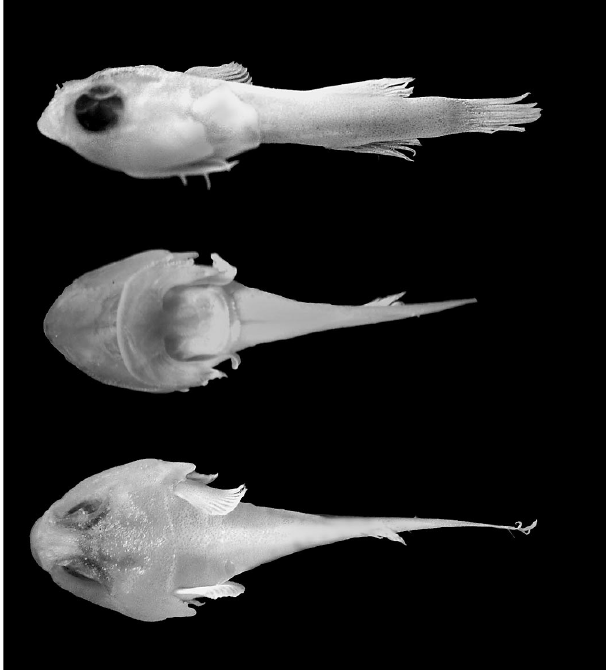
Fig. 1. Acyrtus pauciradiatus , new species.